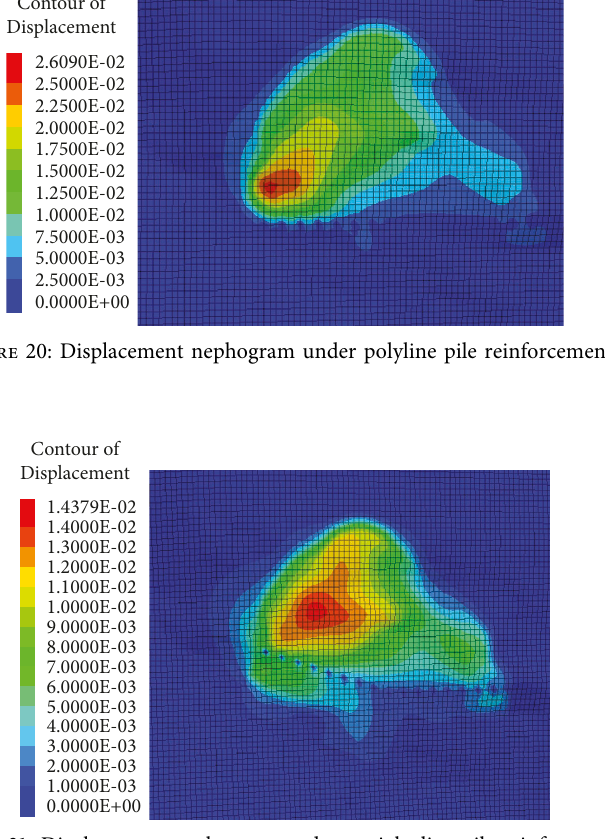
Figure 21: Displacement nephogram under straight line pile